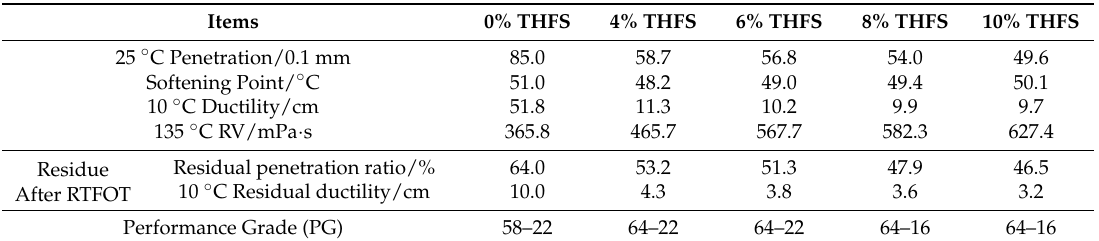
Table 8. Physical properties of Asphalt Binders with Different THFS